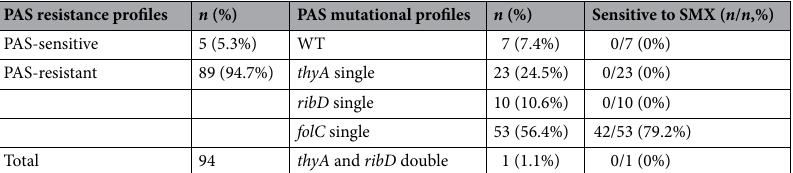
Table 2. PAS resistance, mutational profiles, and distribution ratio of SMX-sensitive isolates. PAS: para - aminosalicylic acid; SMX: sulfamethoxazole; WT: wild-type.